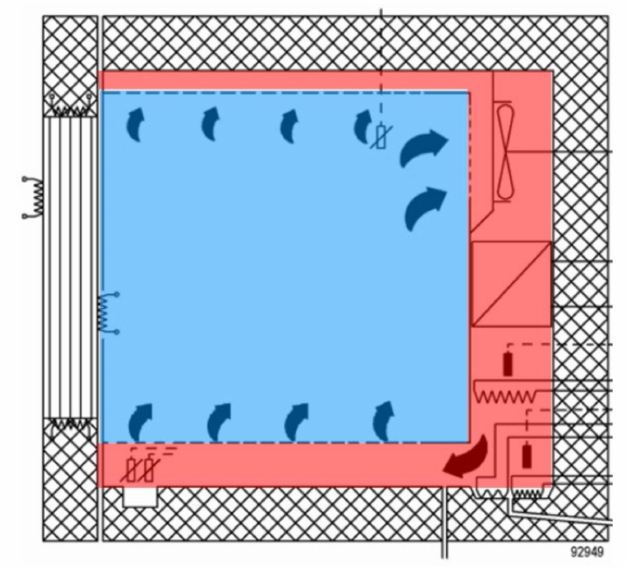
Figure 2. Cross-section of test chamber: usable space (blue); installation space